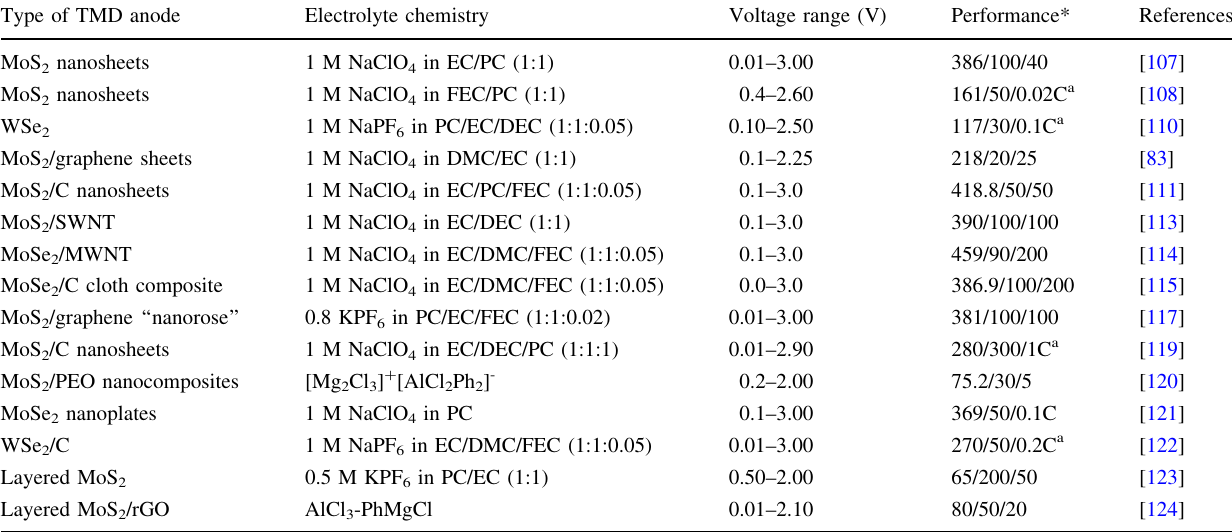
Table 2 Performance of layered TMD anode, in various non-Li metal ion rechargeable battery systems Type of TMD anode Electrolyte